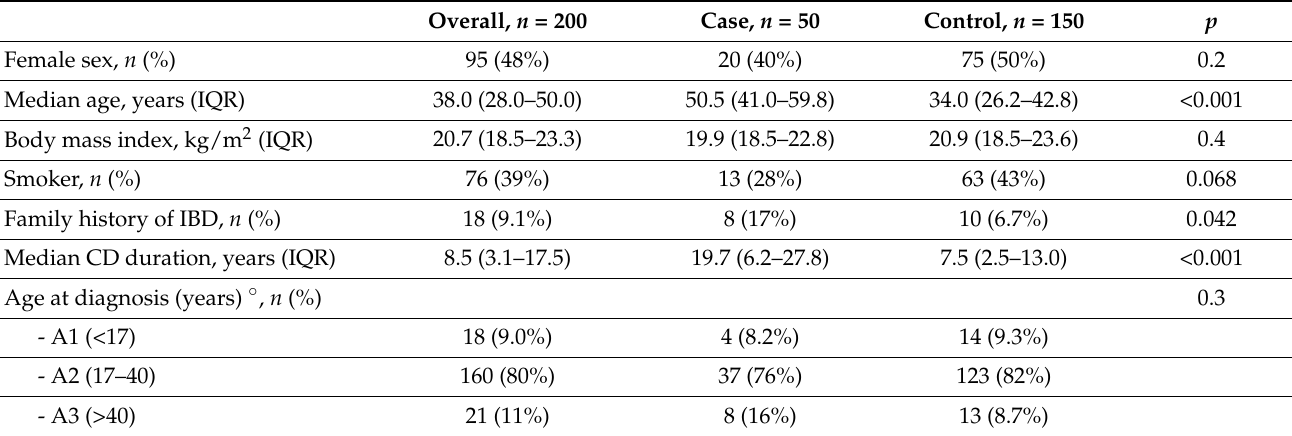
Table 1. Demographic, clinical, and therapeutic characteristics of patients with and without SBN associated with